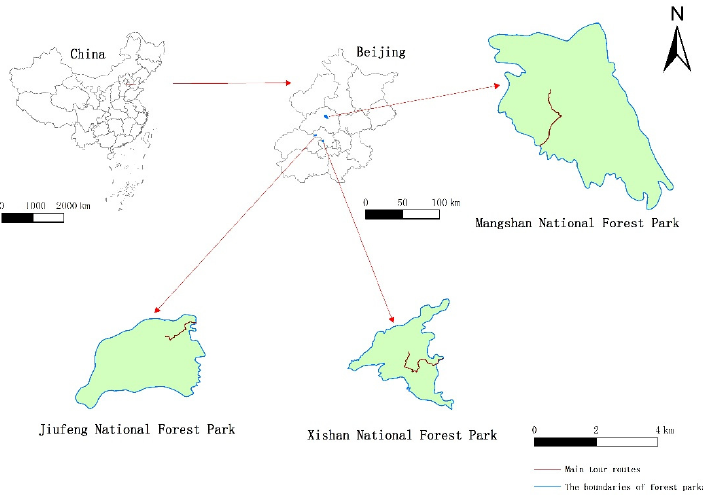
Figure 1. The map of research sites and main tour routes in each forest park.